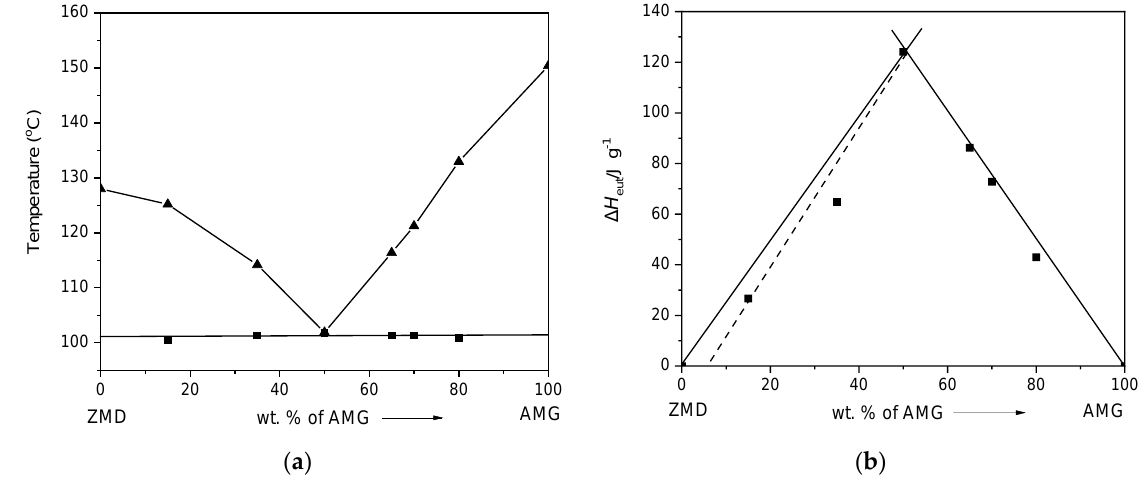
Figure 8. ( a ) Binary melt phase diagram and ( b ) Tammann plot of the AMG-ZMD system. Aqueous Solubility of the Eutectics To measure the solubility, each experiment was performed in a jacketed, circulating flask maintained at 25 °C and in two sets to ensure consistency. Interestingly, the eutectics show significantly improved solubility over the parent drug AMG with a solubility of 1.9 ± 0.01 mg/mL at 25°C (See Figure 9). The AMG-CAF, AMG-NIC and AMG-ZMD eutectics exhibit nearly 2.5-fold,1.5 fold and 1.3 times higher solubility than AMG.